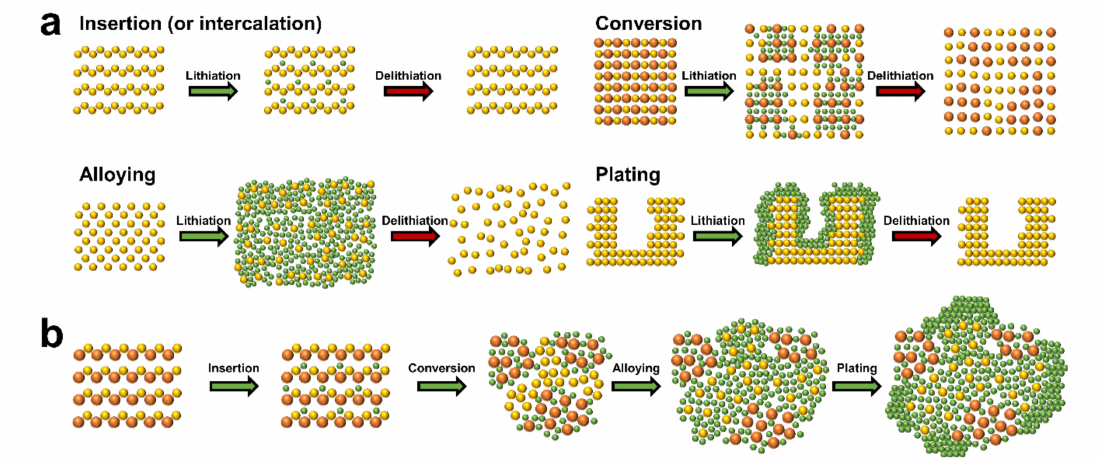
Figure 1. Schematic diagrams of ( a ) basic lithium storage principles of the anode materials and ( b ) microstructural change of ceramic materials during the stepwise lithiation